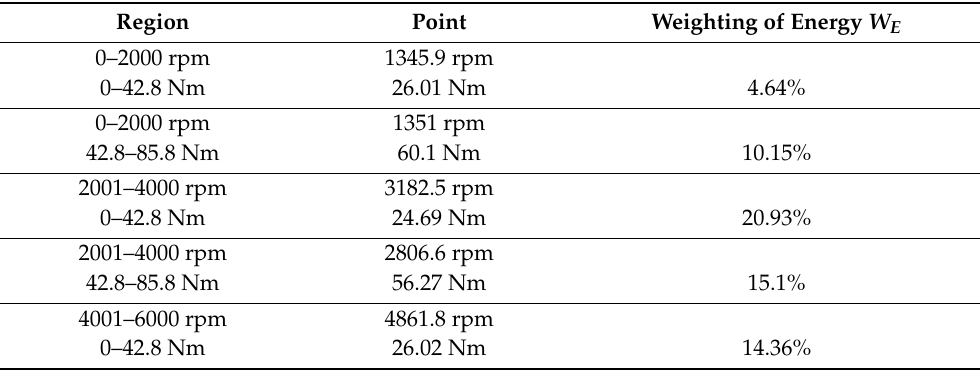
Table 2. Summary of representative